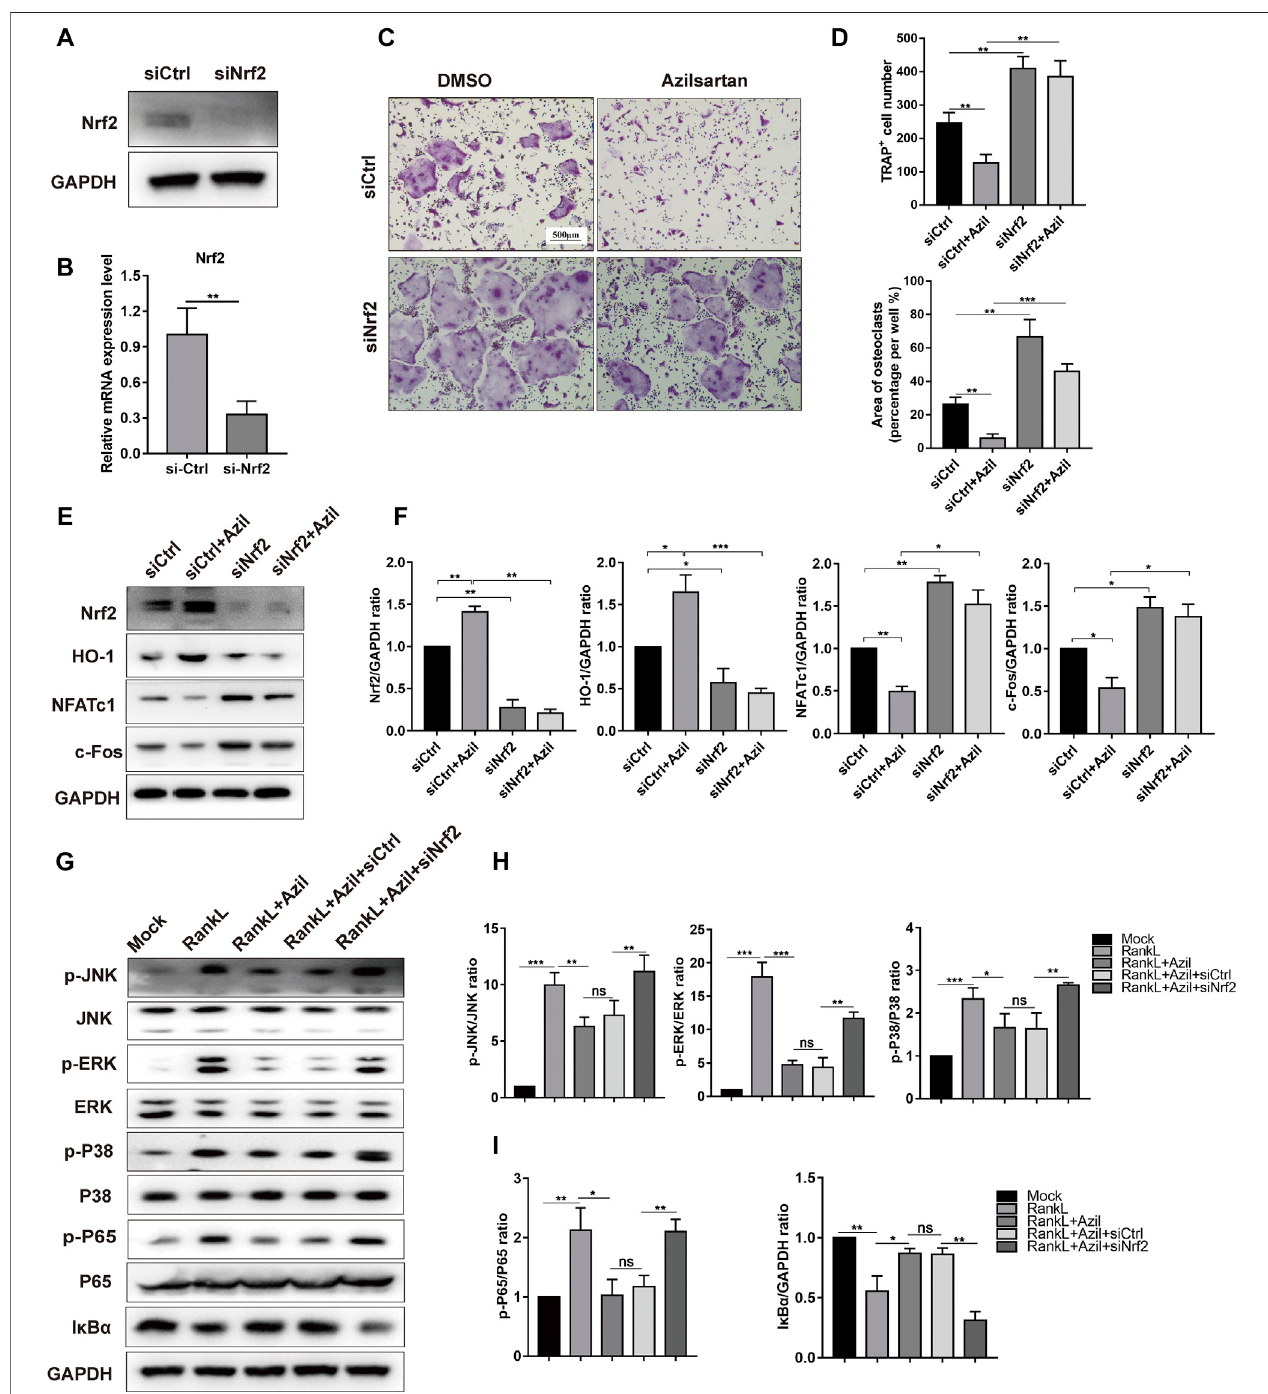
FIGURE 5 | Azilsartan suppresses RANKL-induced osteoclastogenesis in vitro via Nrf2. (A,B) RNAi of Nrf2 was generated by siRNA in BMMs. (C) BMMs were transfected with siNrf2 to reverse the inhibitory effect of Azilsartan in osteoclastogenesis. TRAP staining was performed to detect osteoclast formation. (D) Quantitative analysis of TRAP positive multinucleated cells (nuclei > 3) number per well and the area per well (%) ( n (cid:2) 3). (E) Nrf2 silencing could upregulate the expression of NFATc1 and c-Fos, as evidenced by Western Blot analysis. (F) Quantitative analysis of the band intensity of Nrf2, HO-1, NFATc1, and c-Fos relative to GAPDH using the ImageJ software. (G) The phosphorylated P65, I κ B α degeneration and phosphorylated P38/JNK/ERK were detected by Western blot. BMMs were transfected with siNrf2 for 48 h and then pre-treated with Azilsartan for 2 h before being stimulated by RANKL. The total proteins were harvested after 30 min of RANKL (100 ng/ml) stimulation. (H) Quantitative analysis of phosphorylated band intensity relative to total ERK/P38/JNK using the ImageJ software ( n (cid:2) 3). (I) Quantitative analysis of band intensityofp-P65,I κ B α relativetoP65,GAPDH( n (cid:2) 3).Alldatawereobtainedfromthreeindependentexperimentsandwereshownasmean ± SD.(* p < 0.05,** p < 0.01, *** p < 0.005, ns, no signi fi